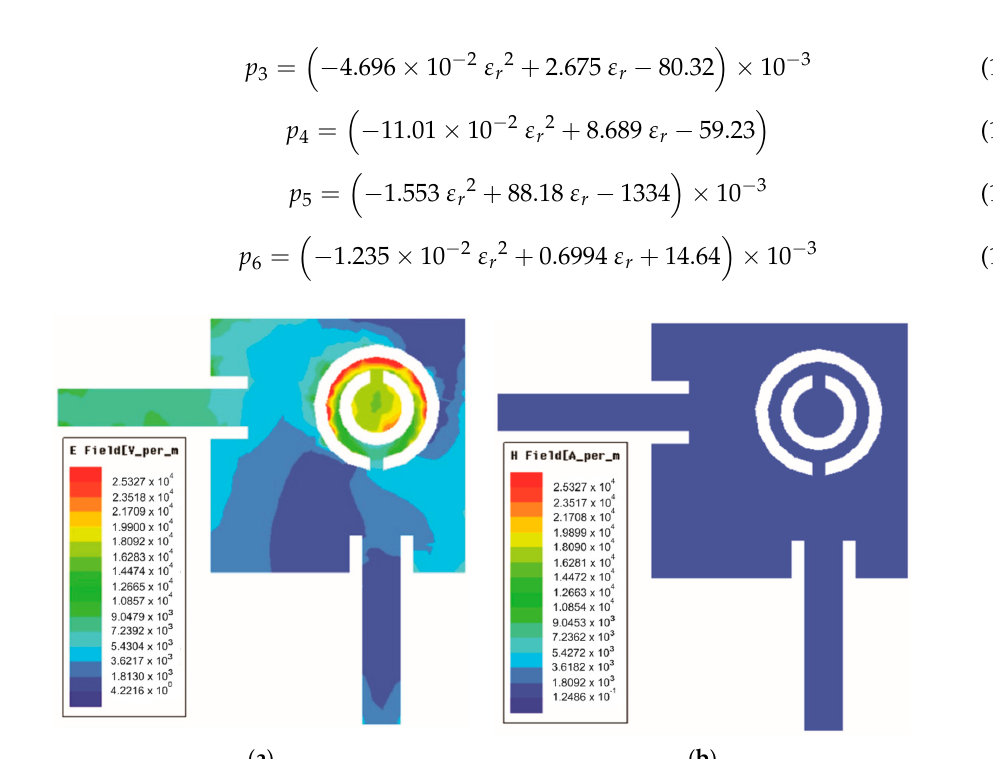
Figure 11. Field distribution on the sensor surface: ( a ) E and ( b ) H.